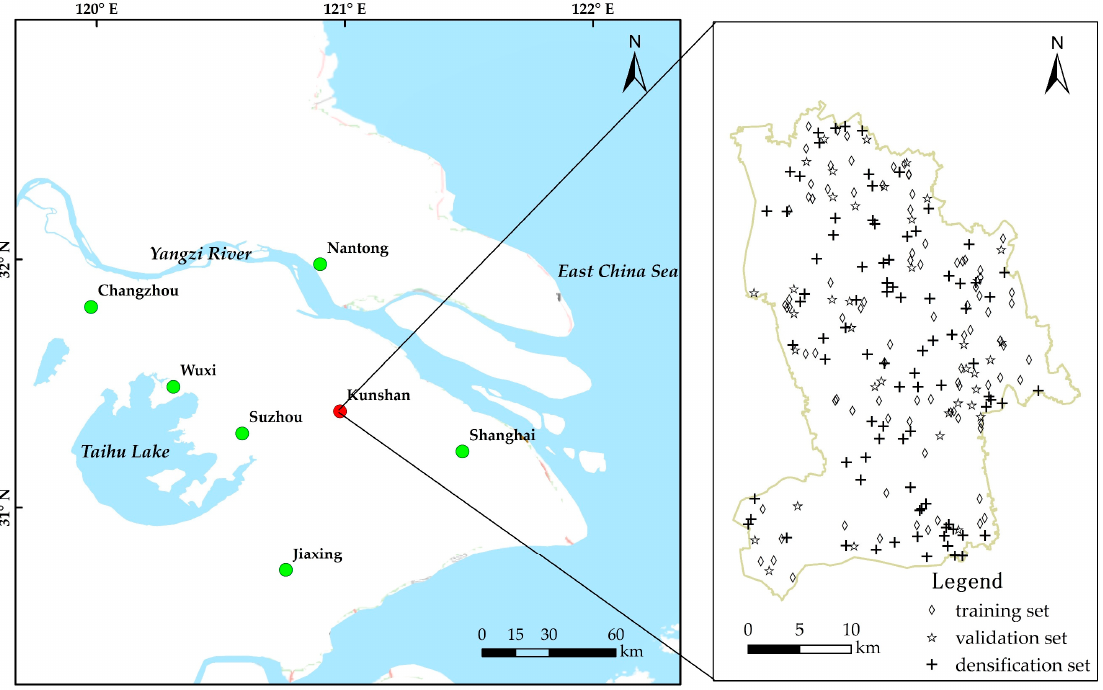
Figure 1. Study site and spatial distribution of each kind of sample. The 126 total samples were divided into two kinds of sets, including 88 training sets (70%) and 38 validation sets (30%), respectively. In addition, another 88 densification sets were added to increase the sampling density.